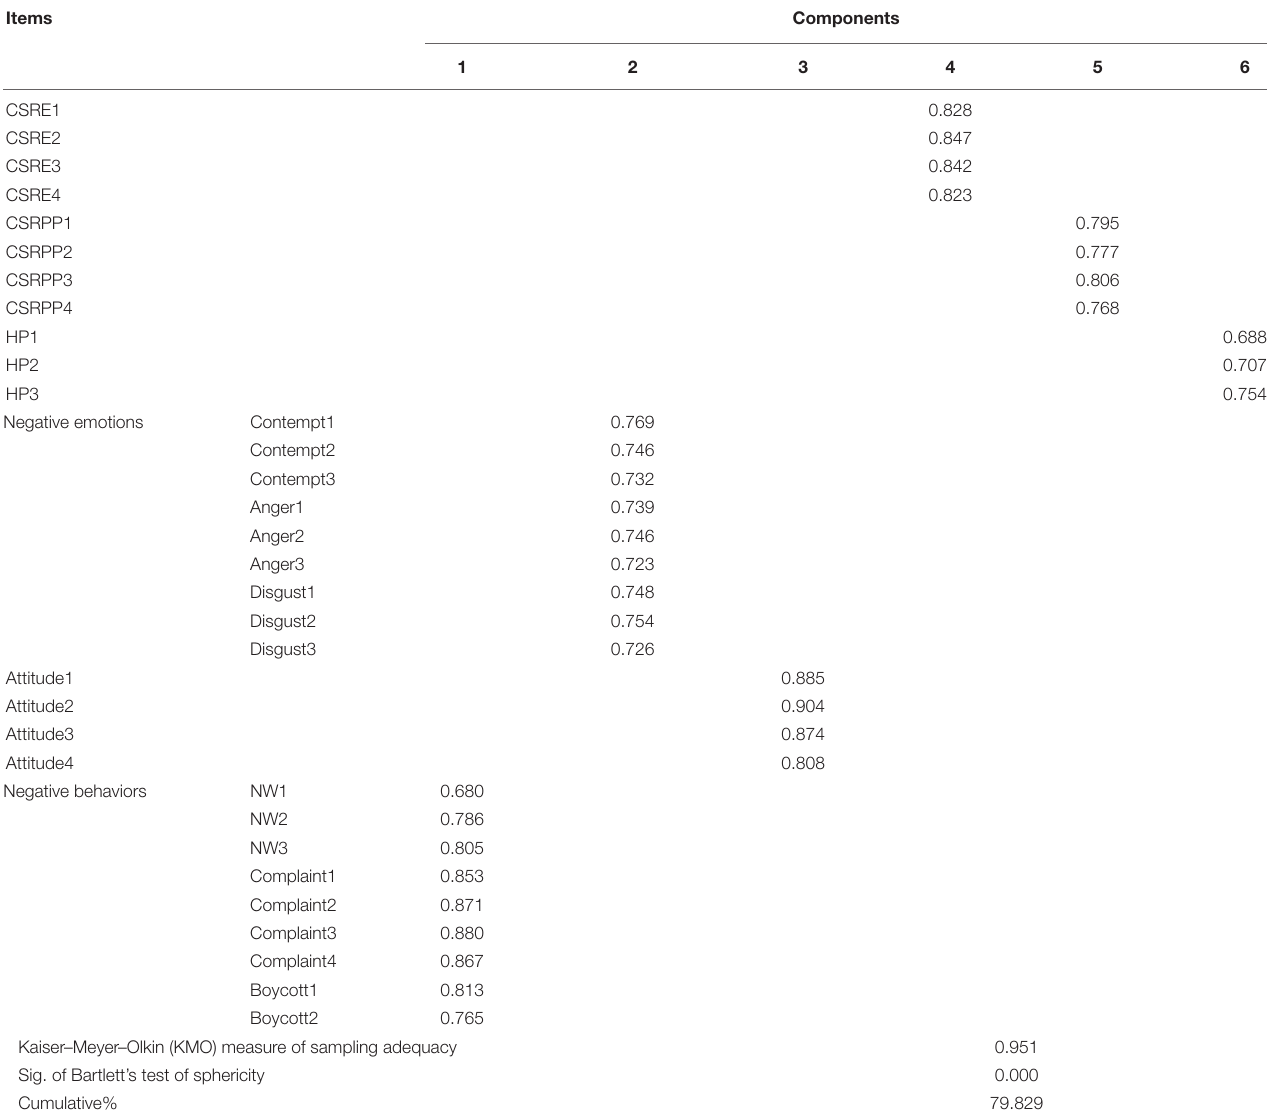
TABLE 2 | Exploratory factor analysis